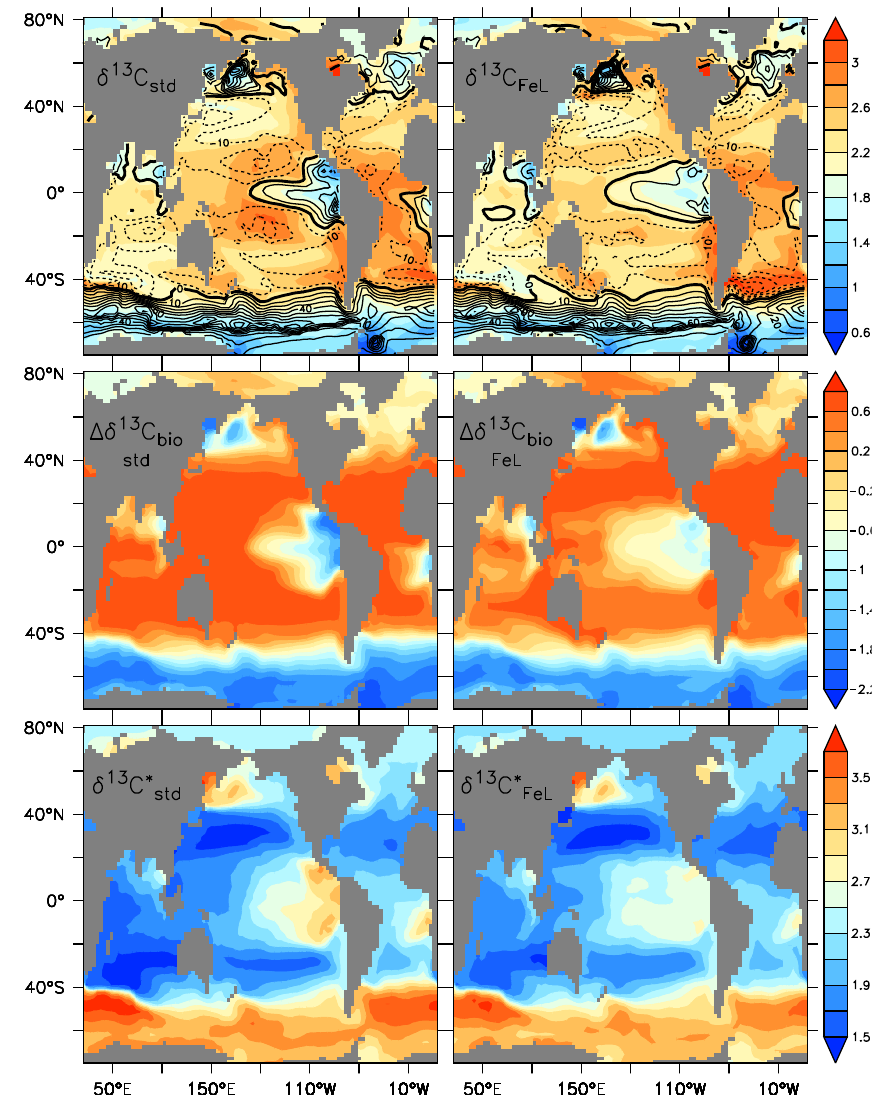
Fig. 3. Preindustrial surface δ 13 C DIC (top; color) and air–sea flux difference 1F 13 dashed), 1δ 13 C bio (center), and δ 13 C ∗ (bottom) as a function of longitude and latitude for the standard model ( std ; left) and model FeL (right). In these experiments δ 13 C of atmospheric CO 2 is fixed at −